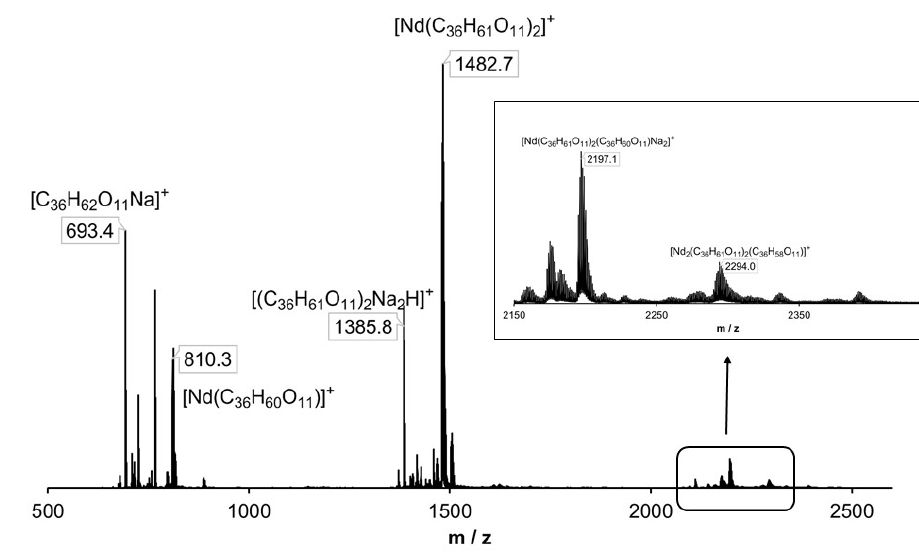
Figure 3: ESI-MS spectrum of complex 2.